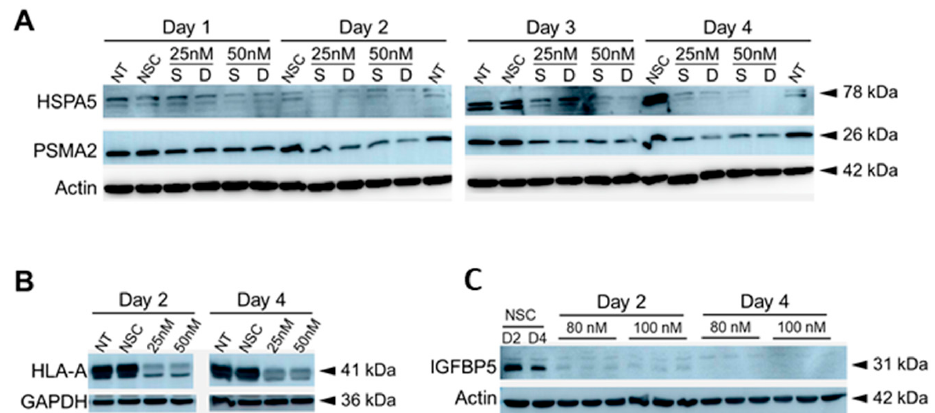
Figure 7. Western blot verification of siRNA-mediated knockdown after ( A ), HSPA5 or PSMA2; ( B ), HLA-A; or ( C ), IGFBP5 knockdown at indicated days post siRNA treatment in U251 cells. Various genes were knocked down with 25, 50, 80, or 100 nM, single (S) or double (D) siRNA treatment. UT: cells not treated with any siRNA; NSC:, cells treated with 100 nM scrambled non-silencing control siRNA. Actin or GAPDH were used as loading controls.